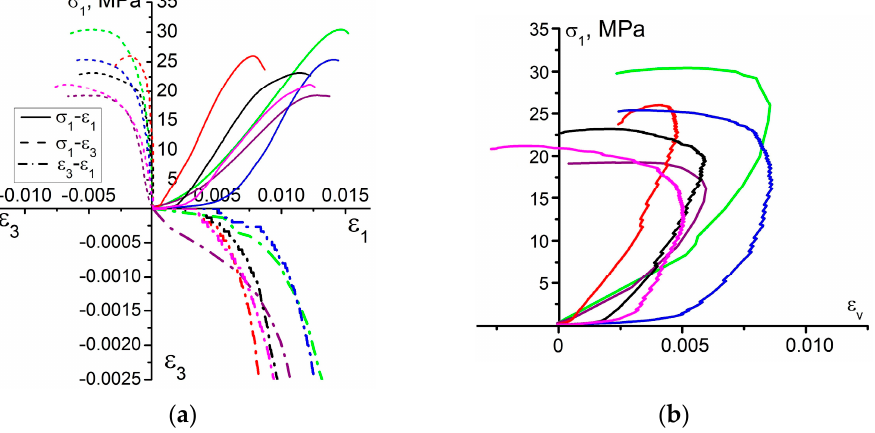
Figure 1. Complete stress-strain diagram of loaded samples: ( a ) curves of dependence σ 1 − ε 1 , σ 1 − ε 3 , and ε 1 − ε 3 ; ( b ) curves of dependence σ 1 − ε v . Different colors correspond to different tested samples.